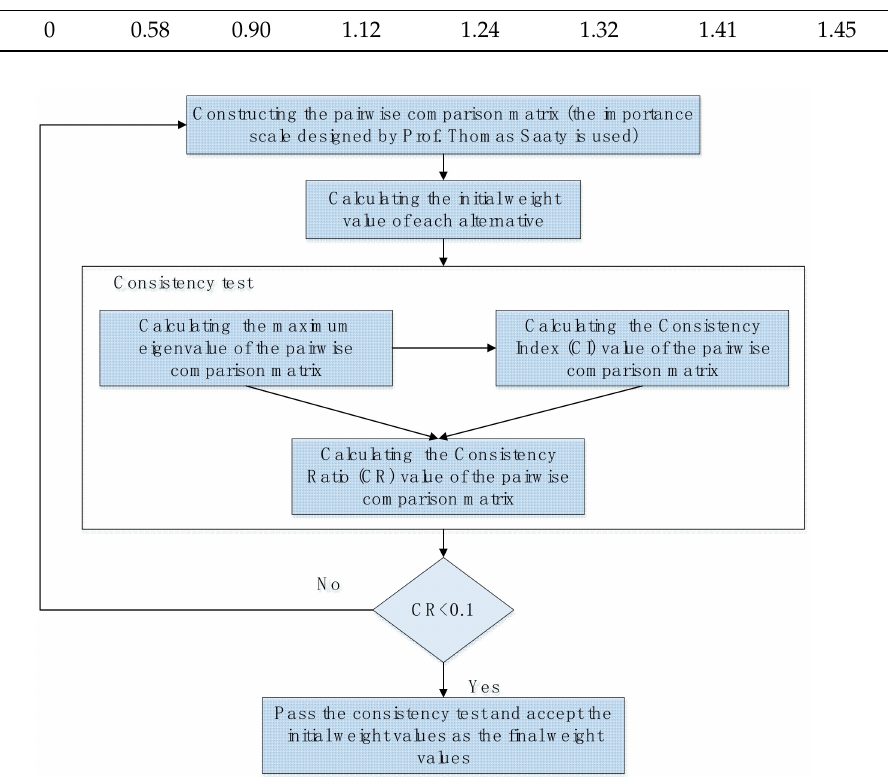
Figure 2. Procedure of